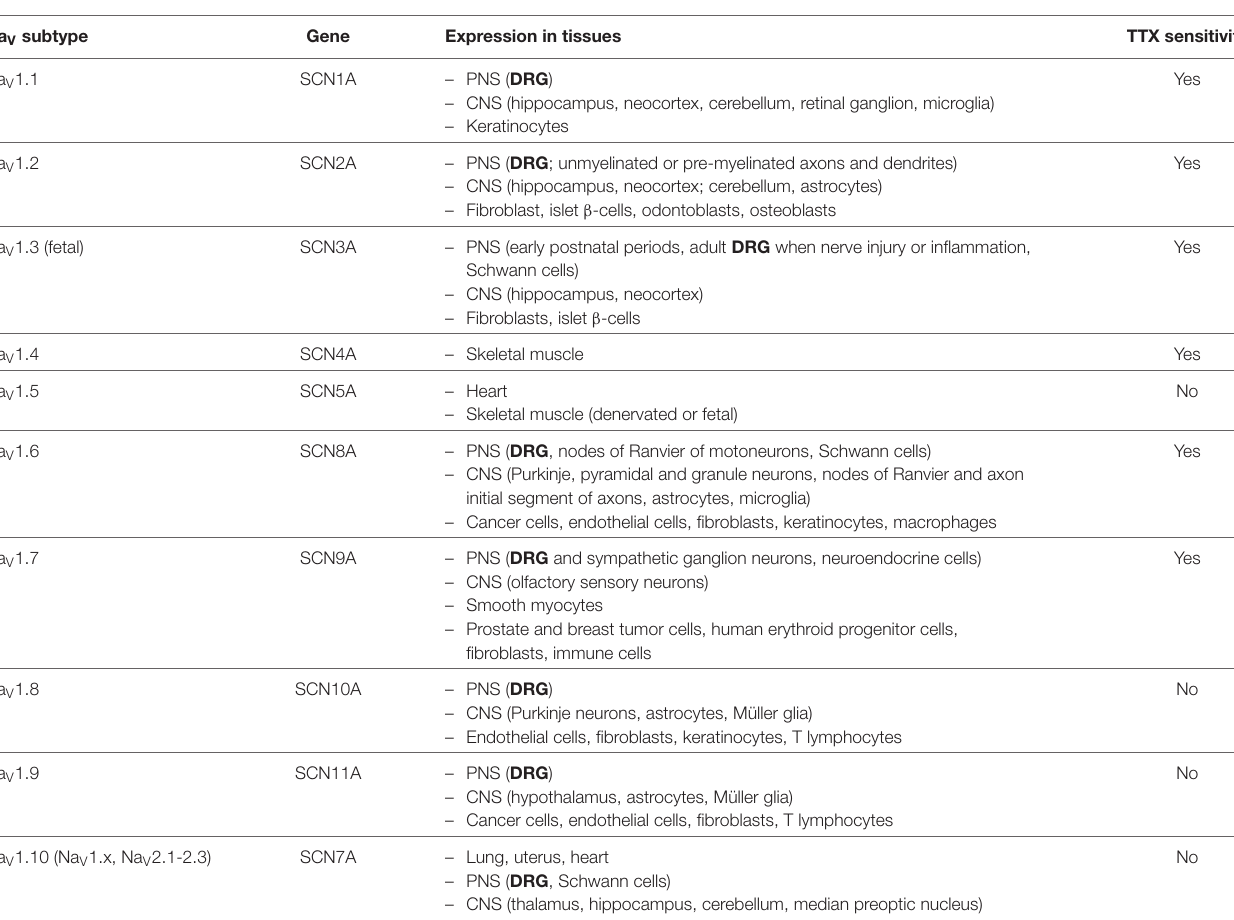
TABLE 2 | Expression in tissues and TTX sensitivity of Na V channel